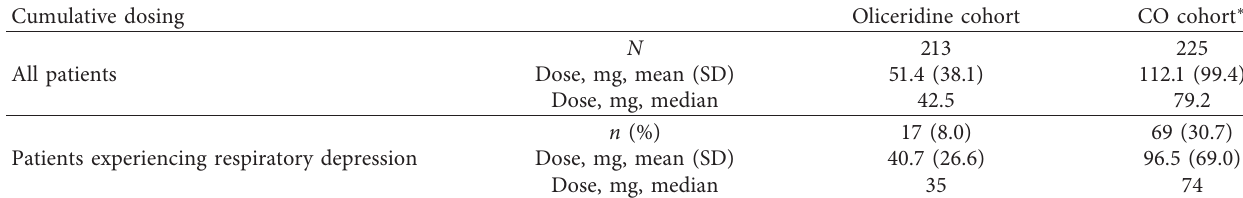
Table 2: Cumulative dose of oliceridine and conventional opioids.